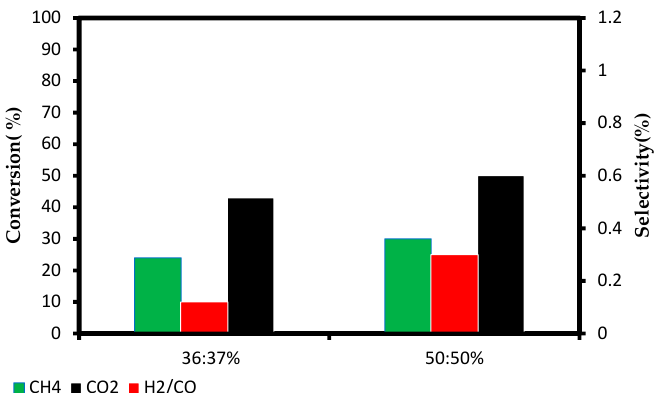
Figure 7. The effect of changing the ratio concentration of the CH 4 :CO 2 reactant a—(2:1) and b—(1:1) over the percentage of their conversion and H 2 /CO ratio for the support-promoter (Mg 1 − x La x O) of the catalyst at 900 °C.